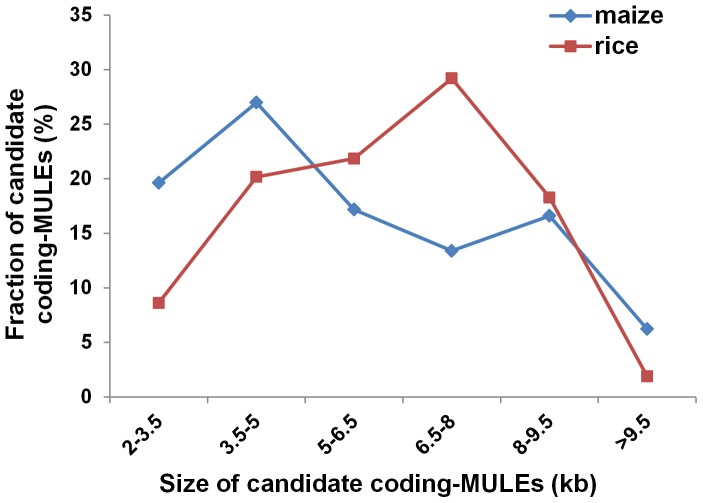
Fraction of candidate coding-MULEs within different size ranges after removing nested TE insertions.